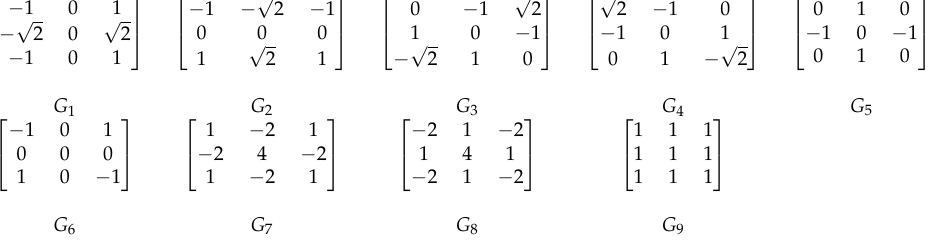
Figure A7. Frei–Chen kernels.